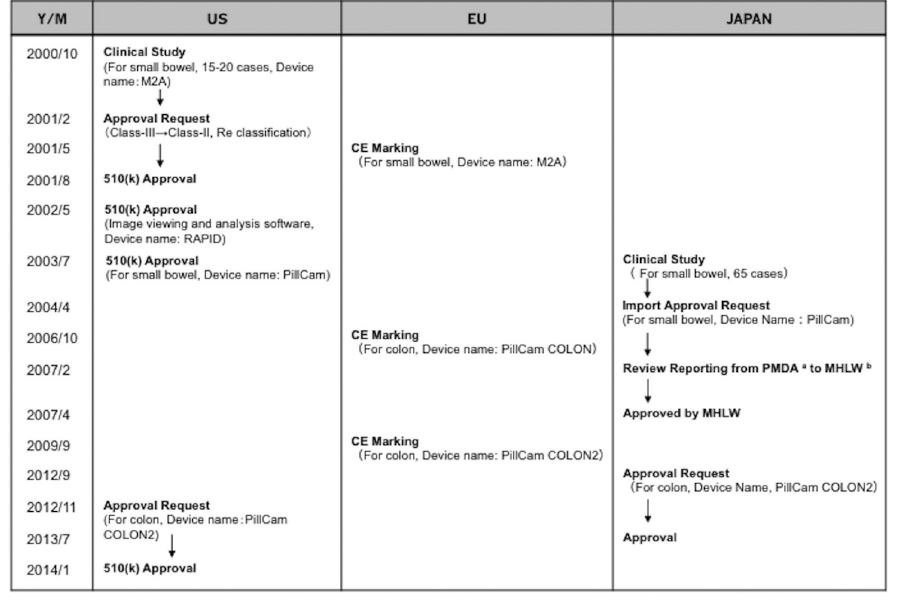
Fig 1. Approval history of capsule endoscope in the US, EU, and Japan. a Pharmaceutical and Medical Device Agency, Japan; b Health, Labour and Welfare Ministry.